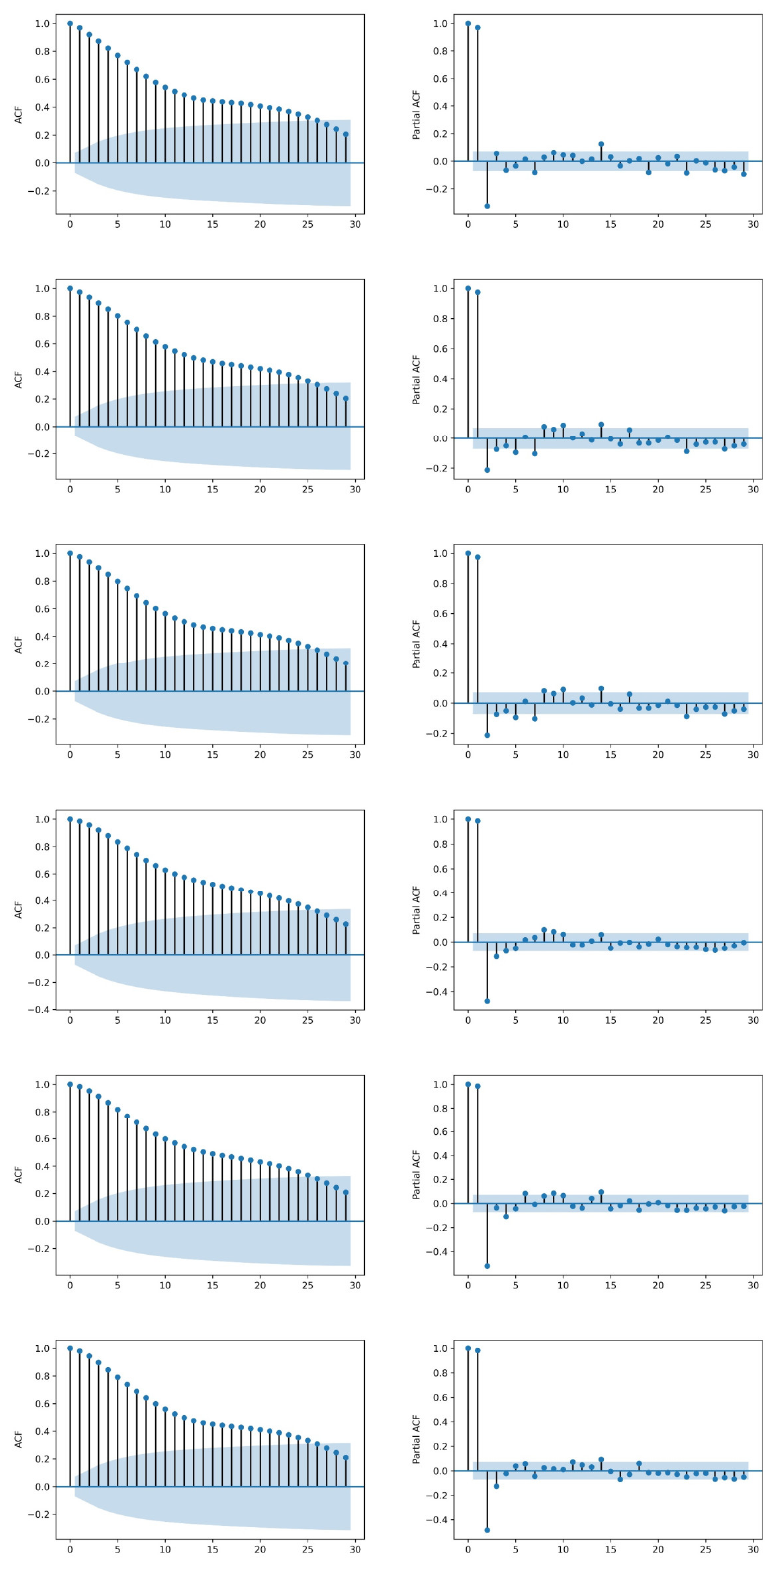
Figure 6. ACF and Partial Autocorrelation Function (PACF) plots for Actual Value (first row), ACF and PACF plots obtained with LSTM (second row), GRU (third row), CNN-LSTM (fourth row), DAQFF (fifth row), FPHFA (sixth row).